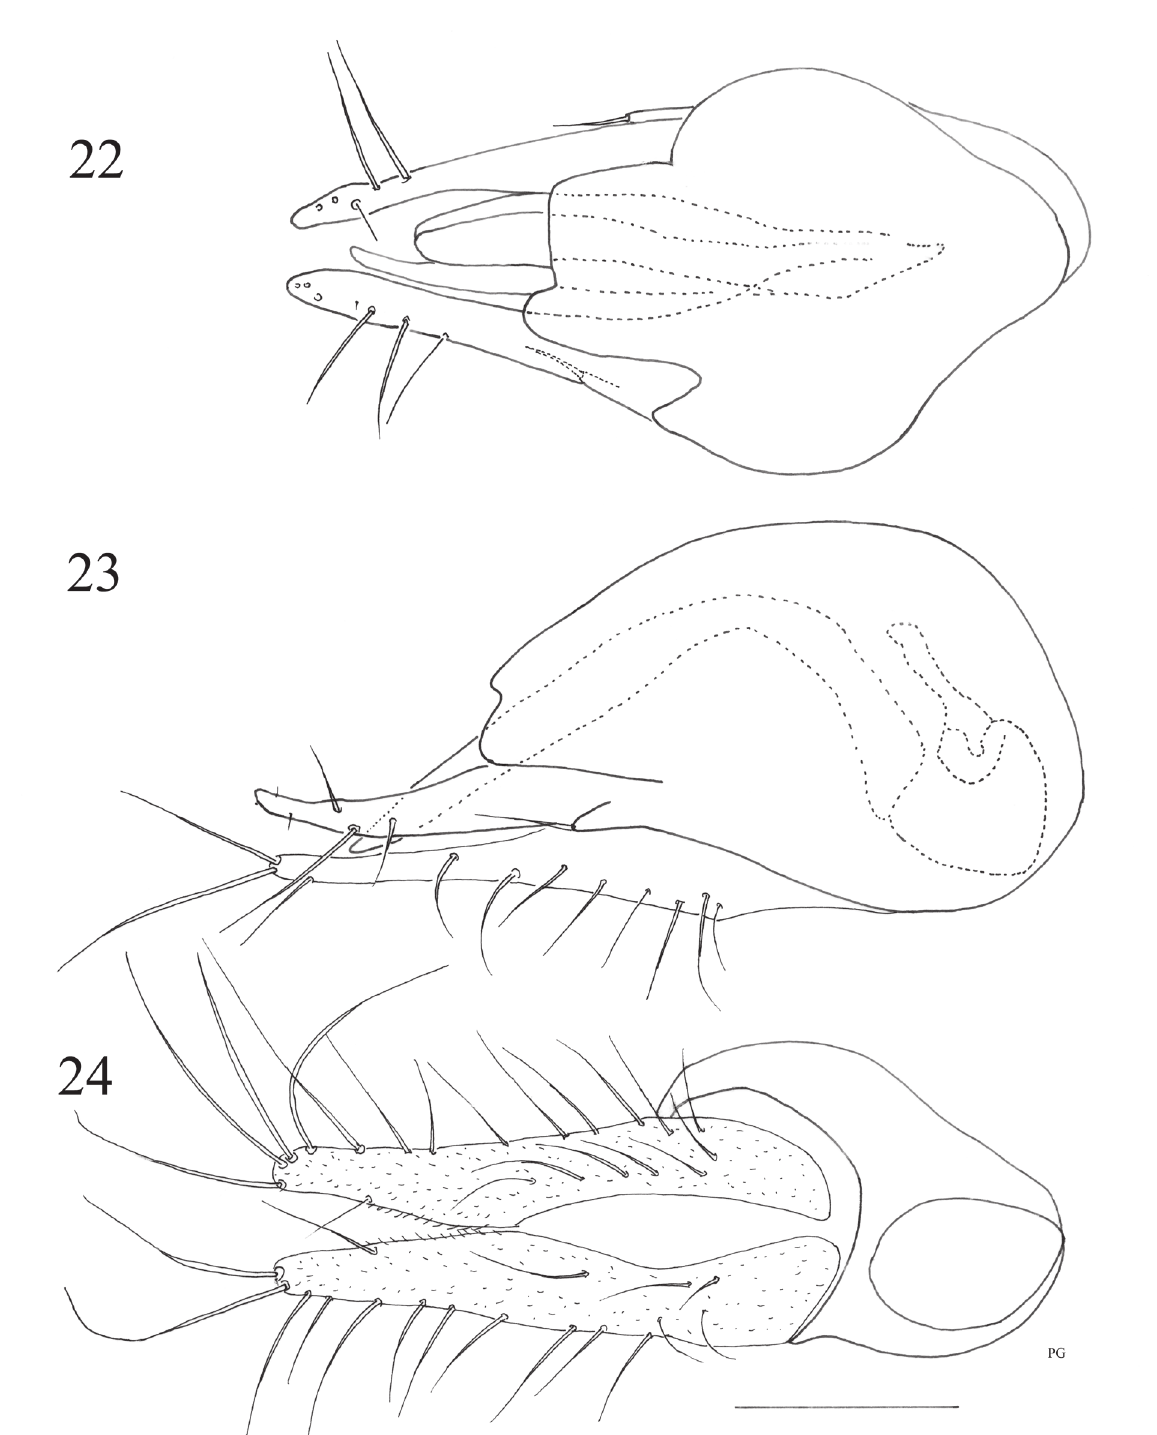
Figs 22–24. Thinophilus parvulus sp. nov., ♂, terminalia. 22 . Genital capsule, ventral view. 23 . Genital capsule, lateral view. 24 . Genital capsule, dorsal